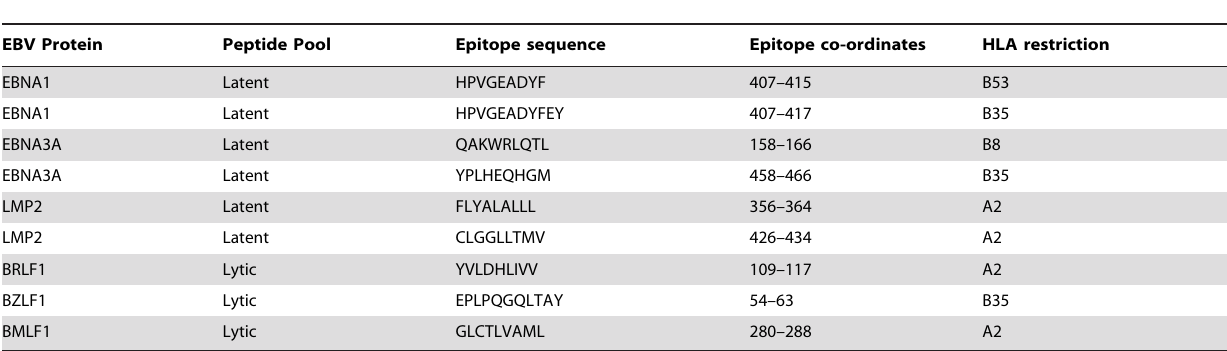
Table 2. EBV lytic and latent peptide